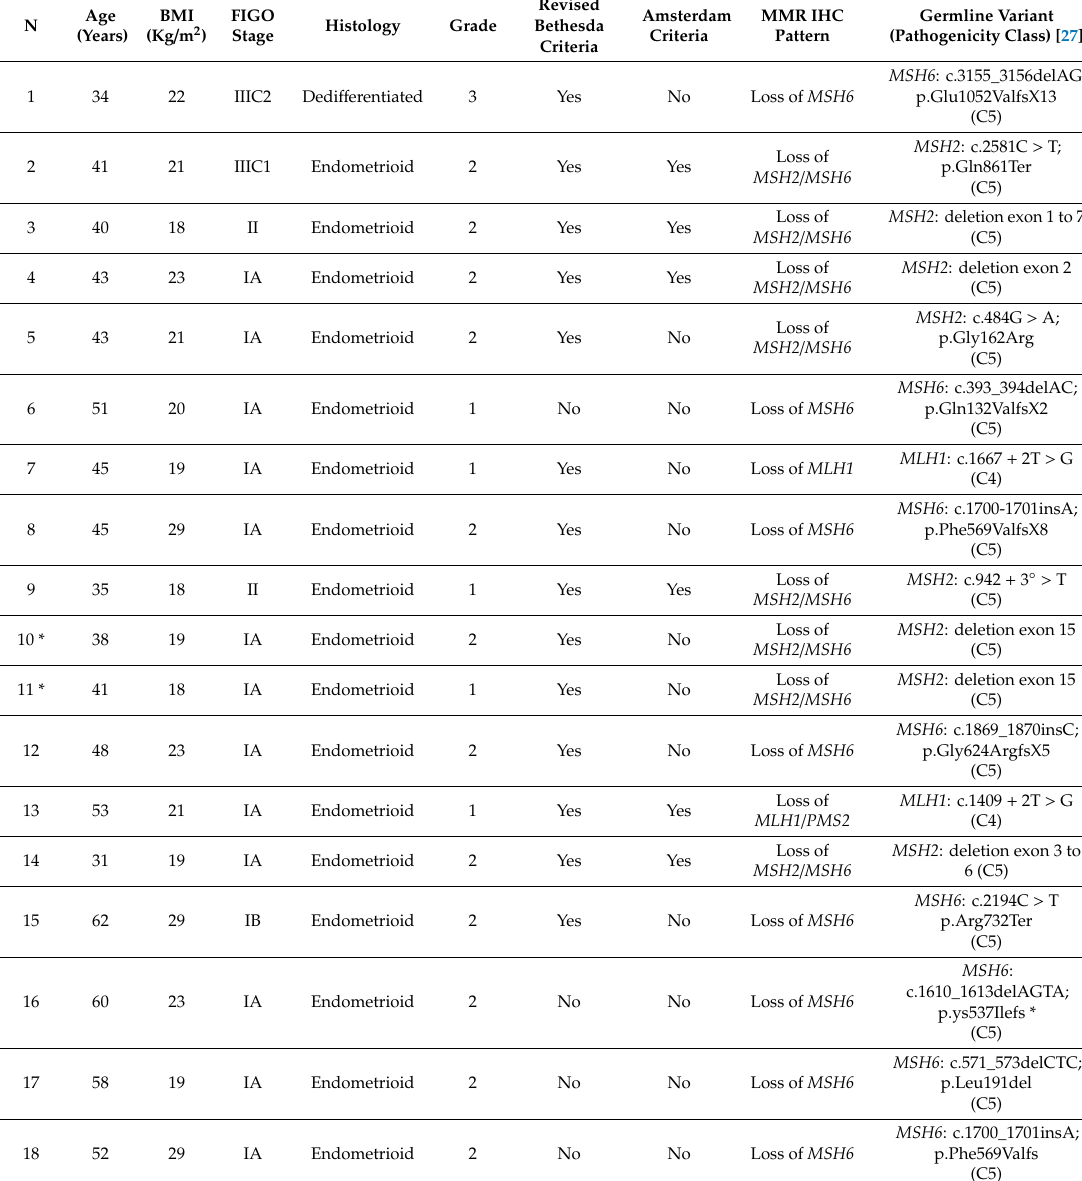
Table 1. Clinical-pathologic and genetic characteristics of Lynch Syndrome (LS)